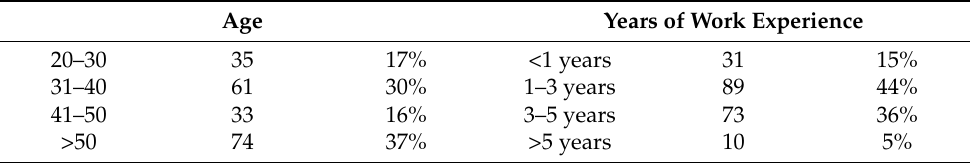
Table 3. Distribution of age and years of work experience of surveyed construction workers.